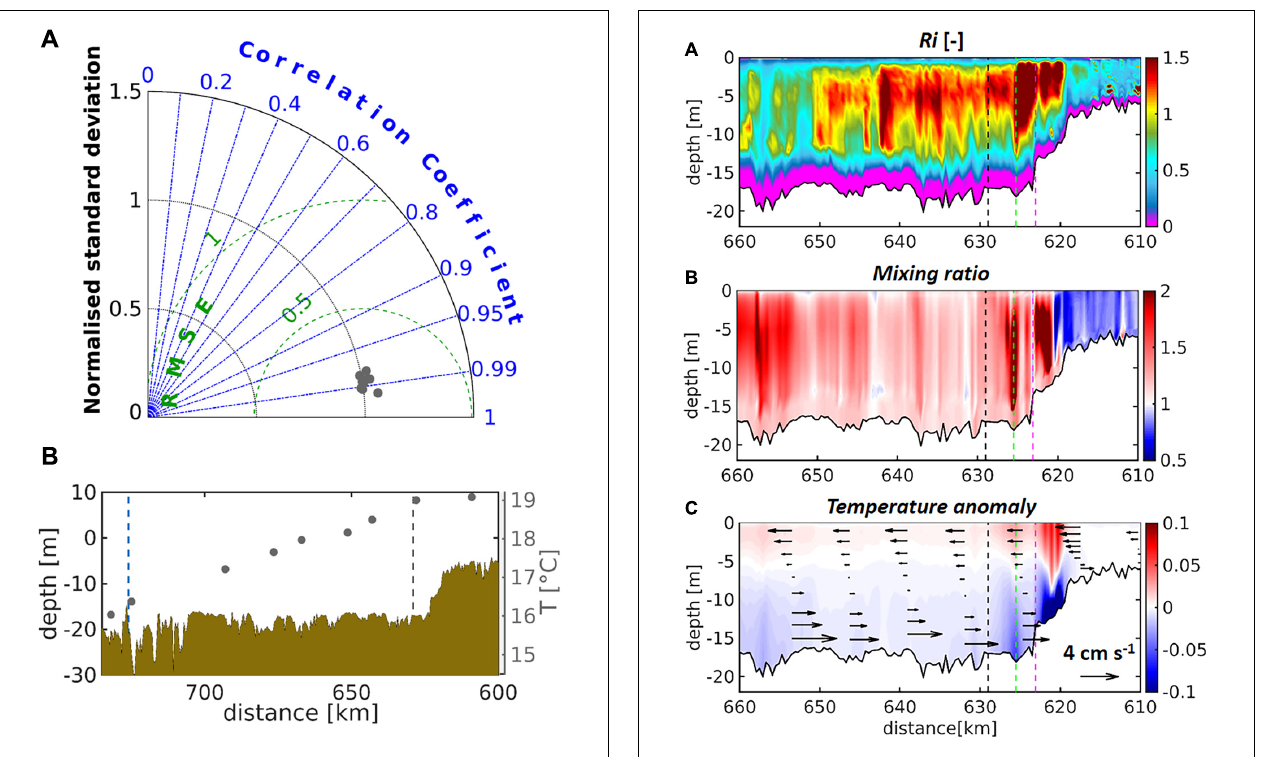
FIGURE 5 | Time-averaged along-channel profiles of simulated (A) Gradient Richardson Number, (B) ratio of flood diffusivity to ebb diffusivity (mixing asymmetry), (C) vertical temperature anomaly, are given for the period May to September 2012. In (C) black arrows represent the local deviation of the along-channel velocity from the barotropic along-channel velocity. The black dashed line marks the Seemannshöft station (see label “HH” in Figure 1 ), whereas green and purple dashed lines indicate the positions of the confluence of northern and southern channel branches and Sankt Pauli gauge station, respectively (see inset in Figure 1